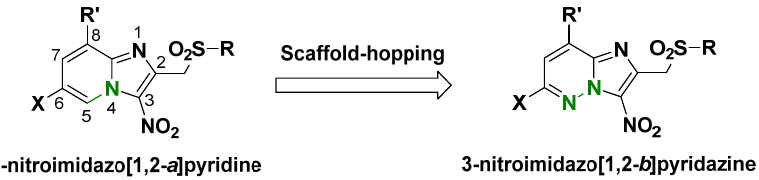
Figure 1. Scaffold-hopping strategy of 3-nitroimidazo[1,2- a ]pyridine moiety into 3-nitroimidazo[1,2- b ]pyridazine